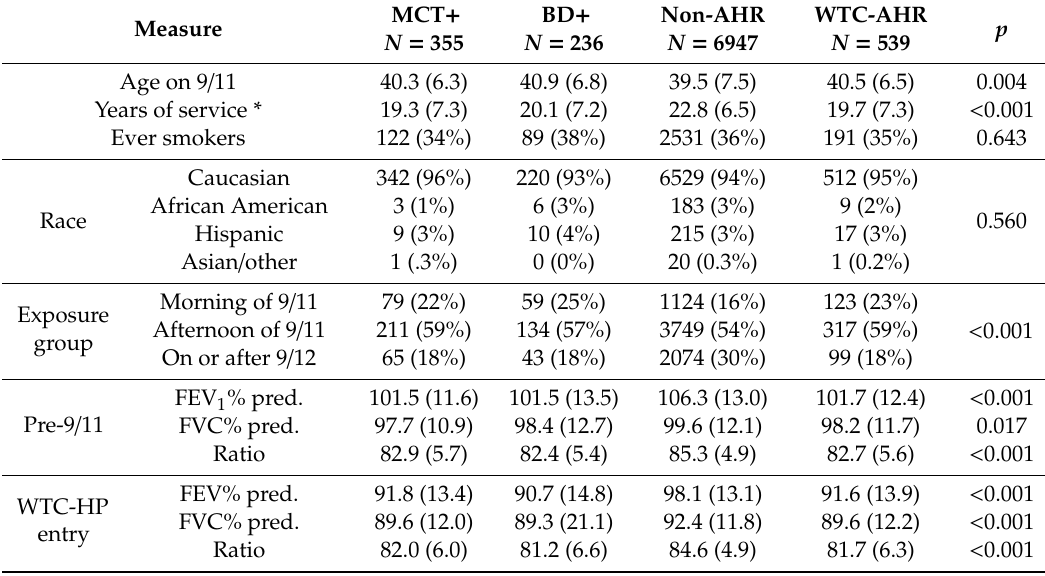
Table 1. Demographic and pulmonary function test data of group.